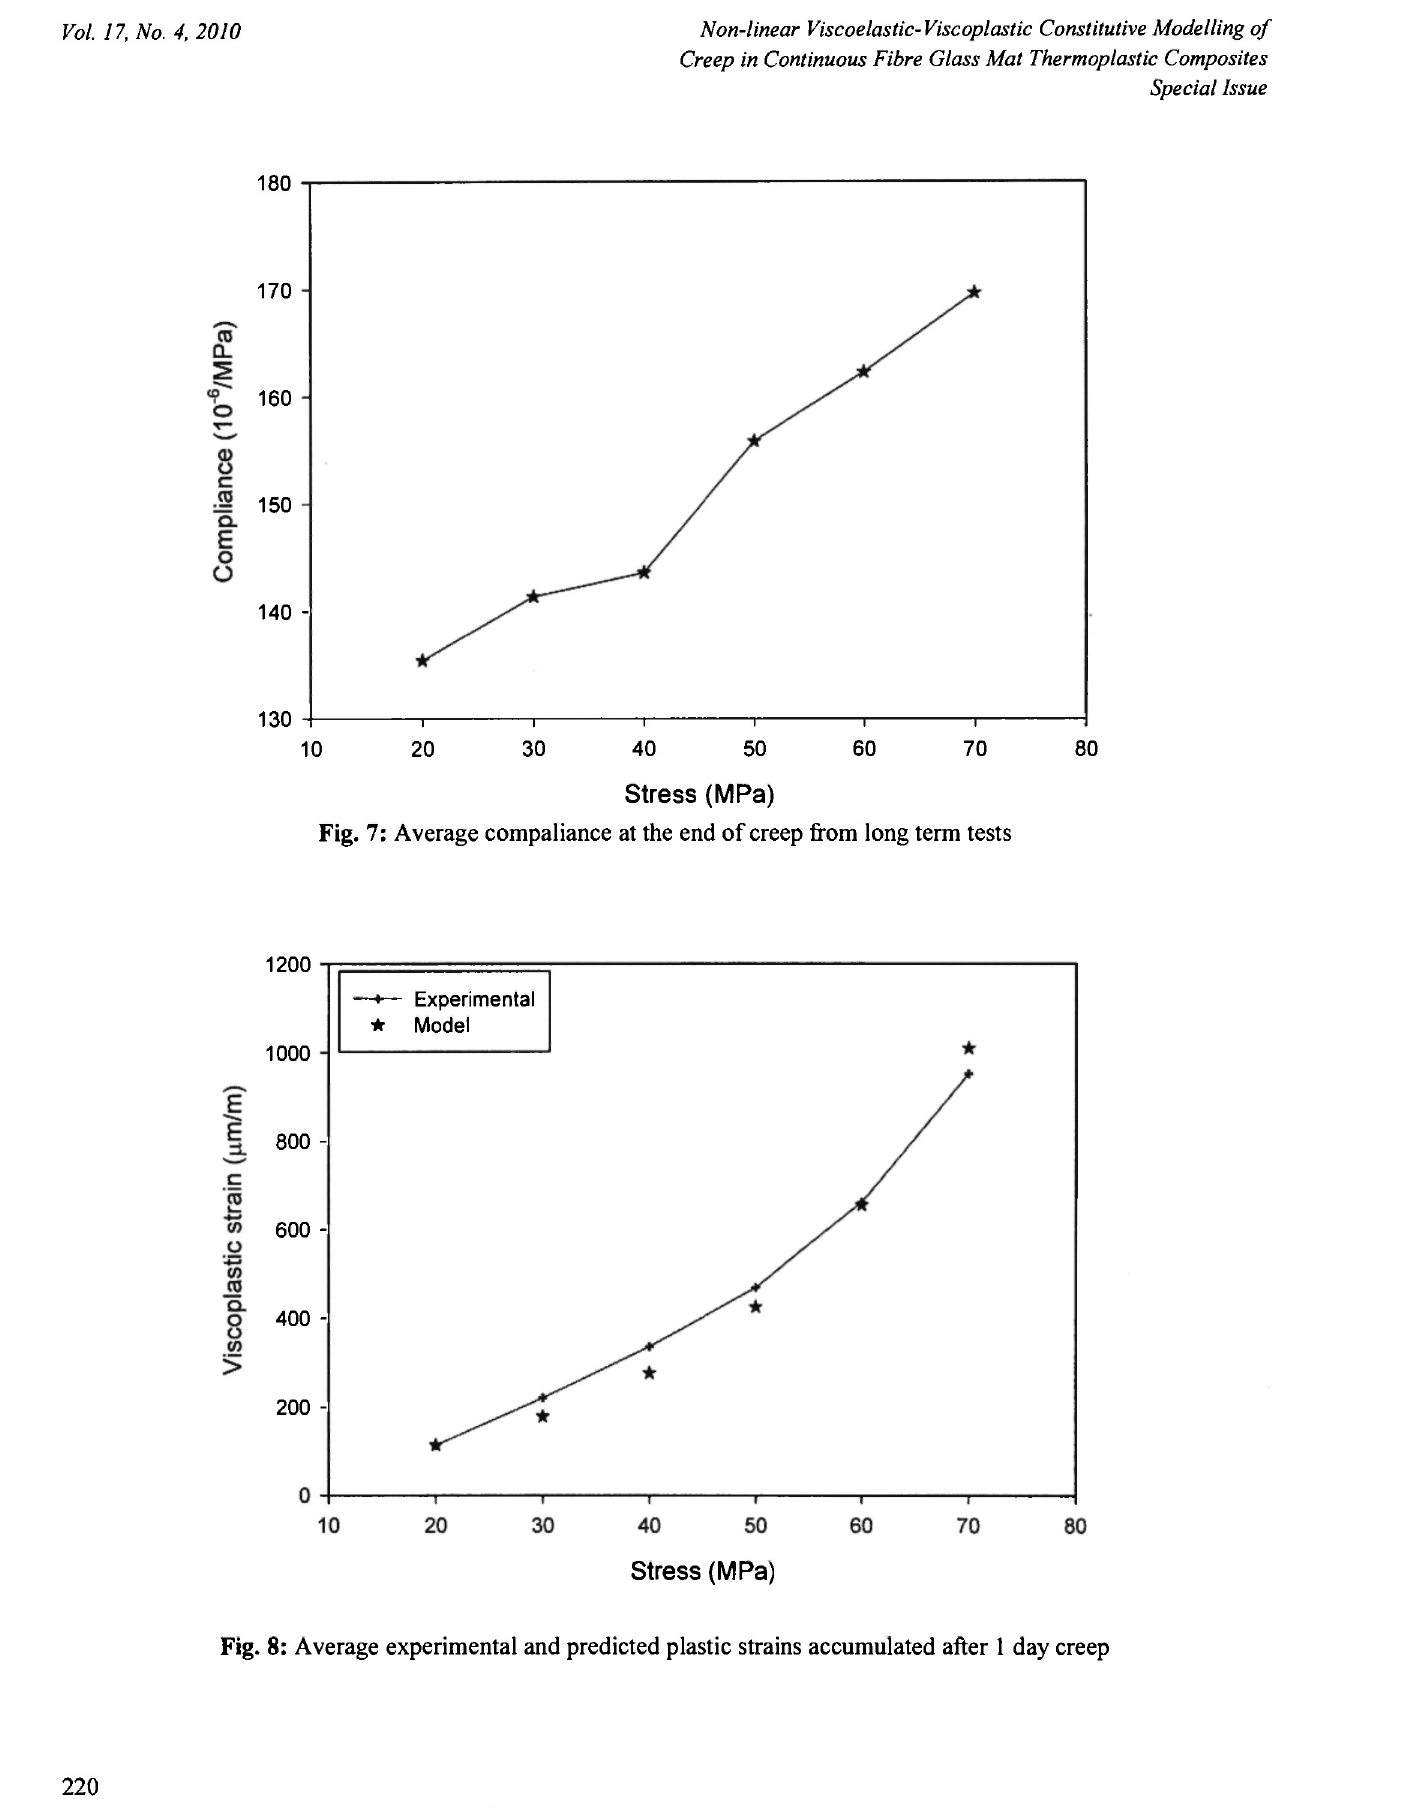
Fig. 8: Average experimental and predicted plastic strains accumulated after 1 day creep